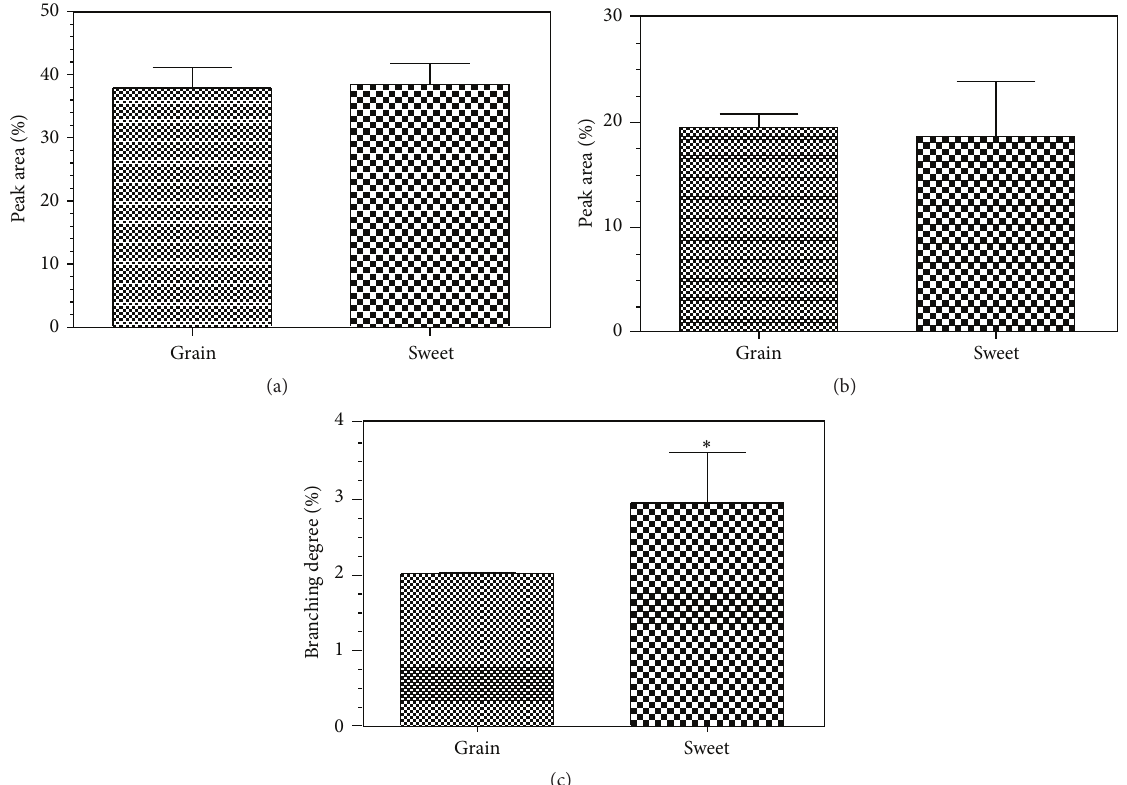
Figure 9: Comparison of peak 1 area (a), peak 2 area (b), and the branching degree (peak 1/peak 2) (c) from GPC profile between sweet and grain varieties starches. ∗ indicates that significant difference was noticed ( 𝑝 < 0.05 ).